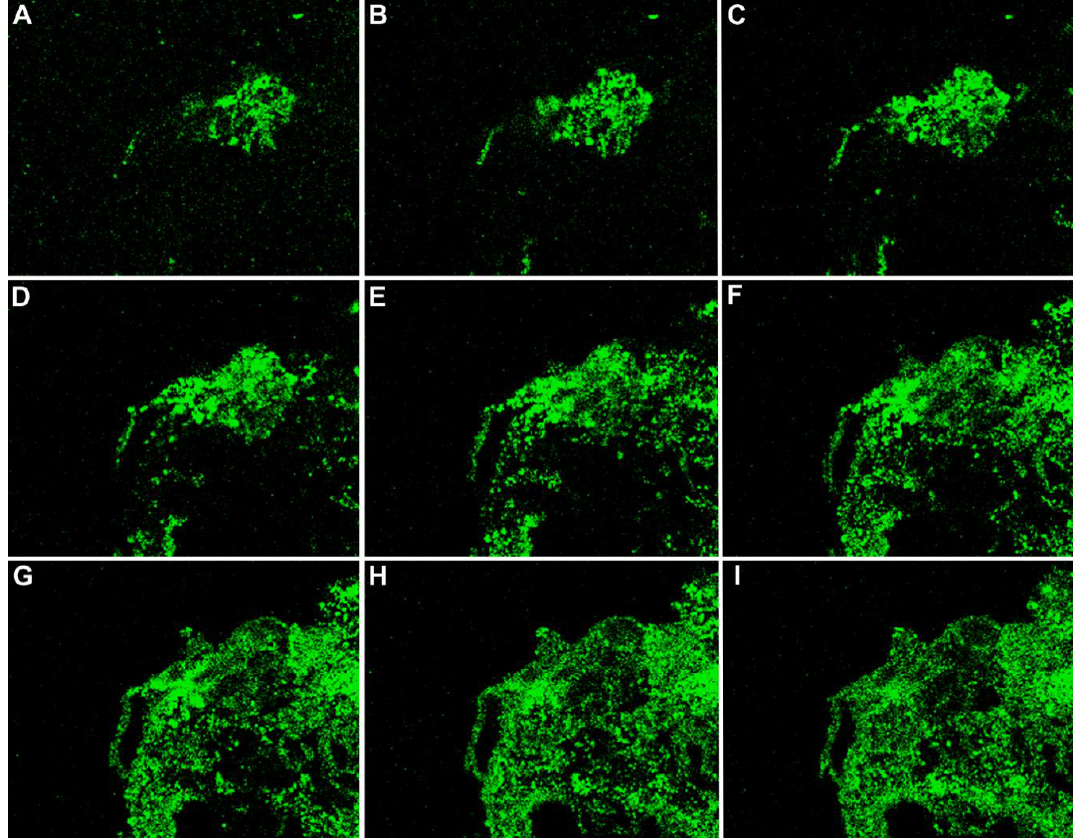
Figure 9. Vesicle of wild type herpes zoster. The VZV glycoprotein gC is a component in the envelope of a VZ virion; every vesicle is filled with virions. The protein is immunolabeled green by a monoclonal antibody probe. The nine micrographs show images of the abundant VZV gC protein from serial sections cut through a herpes zoster vesicle from an edge to the center ( A – I ). Magnification = 200X.